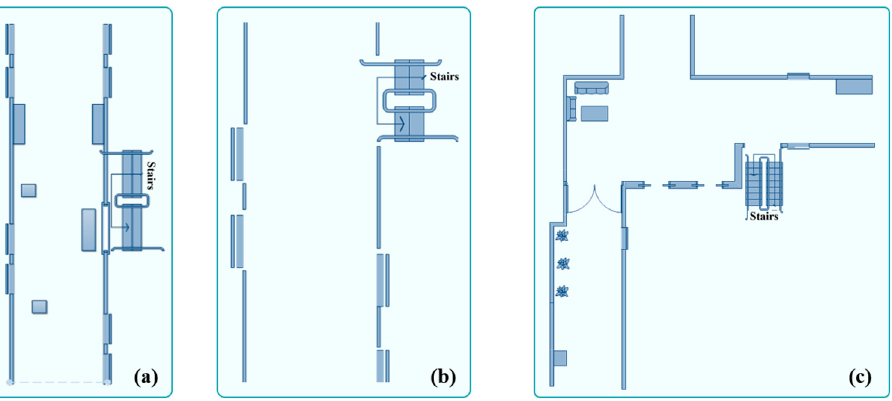
Figure 8. Experimental environments of the three scenarios considering different kinds of human errors. ( a ) S-shape path, ( b ) Corridor with walls, ( c ) L-shape corridor. errors. ( a ) S-shape path, ( b ) Corridor with walls, ( c ) L-shape